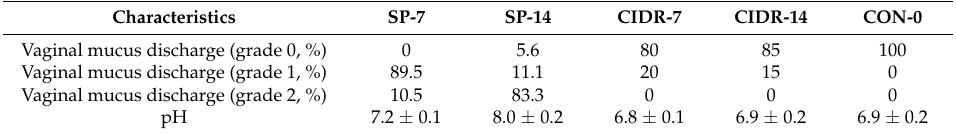
Table 1. Characteristics of vaginal mucus discharge (0—negligible or no discharge; 1—some amount but clear discharge; 2—abundant amounts and hemorrhagic or purulent) and pH at intravaginal device withdrawal in sheep treated with one progestagen-impregnated sponge for either 14 (group SP-14; n = 20) or 7 days (group SP-7; n = 20), one progesterone-loaded CIDR for either 14 (group CIDR-14; n = 20) or 7 days (group CIDR-7; n = 20), or no treatment (group CON-0; n = 20).